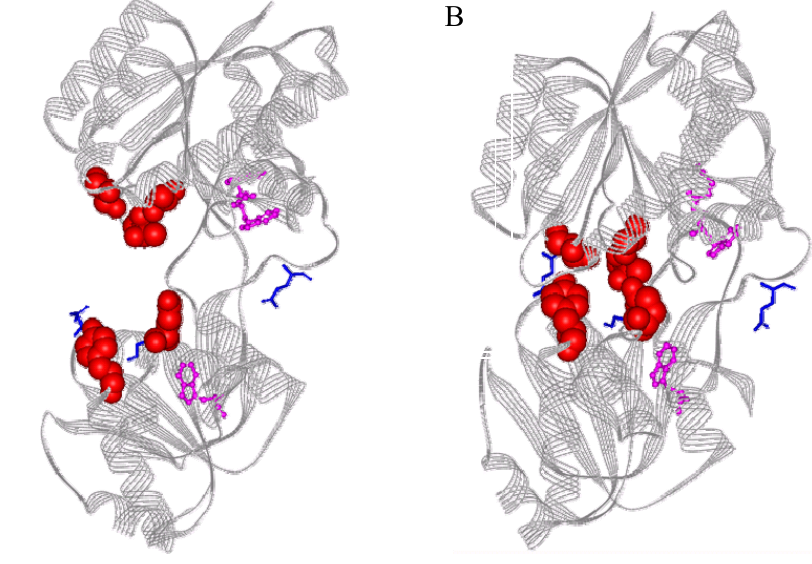
Figure 1. Fluorophore modification sites on open (A) and closed (B) forms of LIVBP X-ray 3D structures (PDB: 1Z16 and 1Z15, respectively). Trp residues are shown in stick and ball form. The residues (Ser79, Ala100, Thr102, Tyr202, and Glu226) shown in space fill style are predicted to make up the substrate binding domain. The residues selected for substitution to Cys (Gln149, Gly227, and Gln254) are shown in stick form.